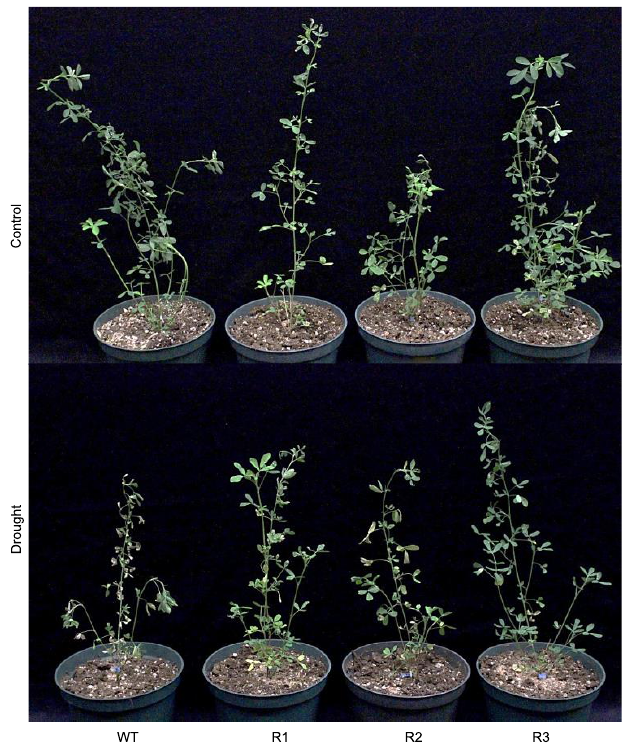
Figure 3. Representative SPL9 -RNAi and WT alfalfa plants after 12 days under well-watered control and drought conditions.